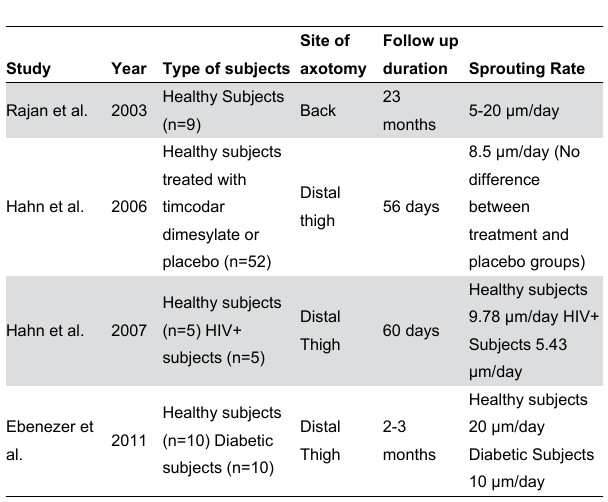
Table 1. Experimental findings from human studies utilizing intracutaneous axotomy